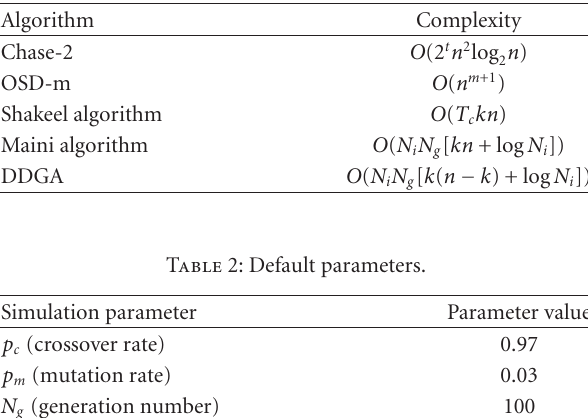
Table 1: Complexity of Chase-2, OSD-m, Shakeel, Maini, and DDGA algorithms.